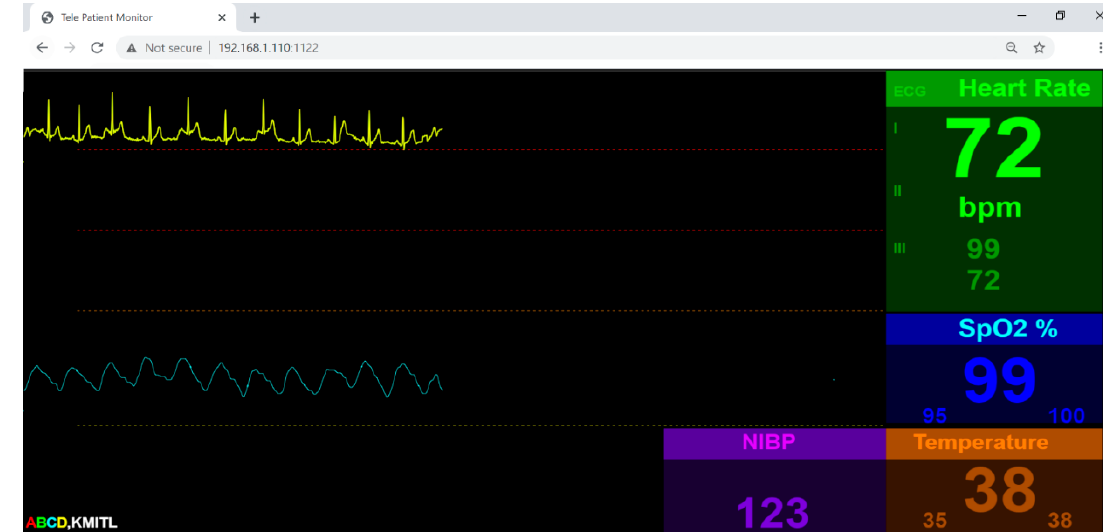
Figure 11. Vital-sign monitoring page.